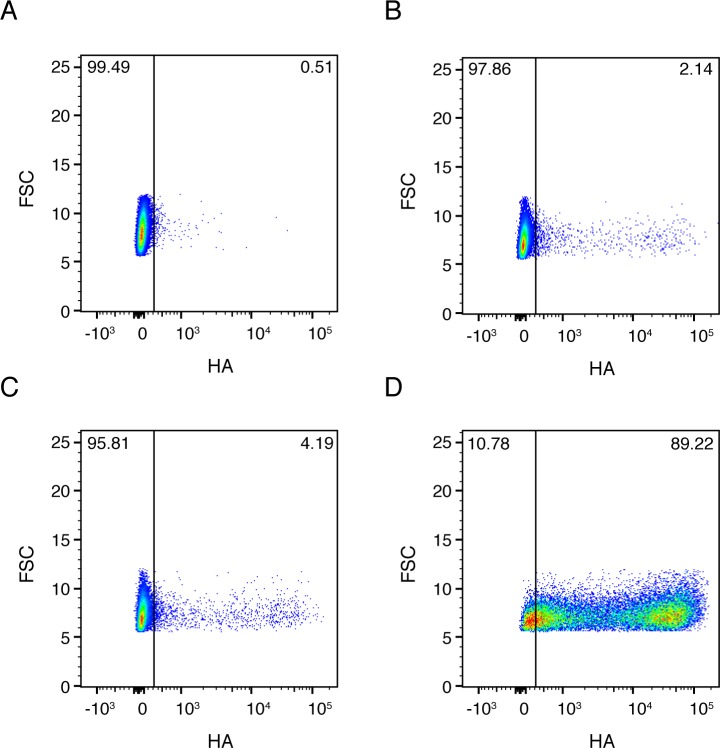
Full flow cytometry data for Figure 2B.A549 cells were infected at an MOI of 0.1 as calculated by TCID50 on MDCK-SIAT1 cells. (A) Uninfected gating control. (B) Cells infected with the wild-type virus stock used in our experiments. (C) Cells infected with synonymously barcoded virus stock used in our experiments. (D) Cells infected with a stock of wild-type virus propagated at a high MOI, and therefore enriched in defective particles.